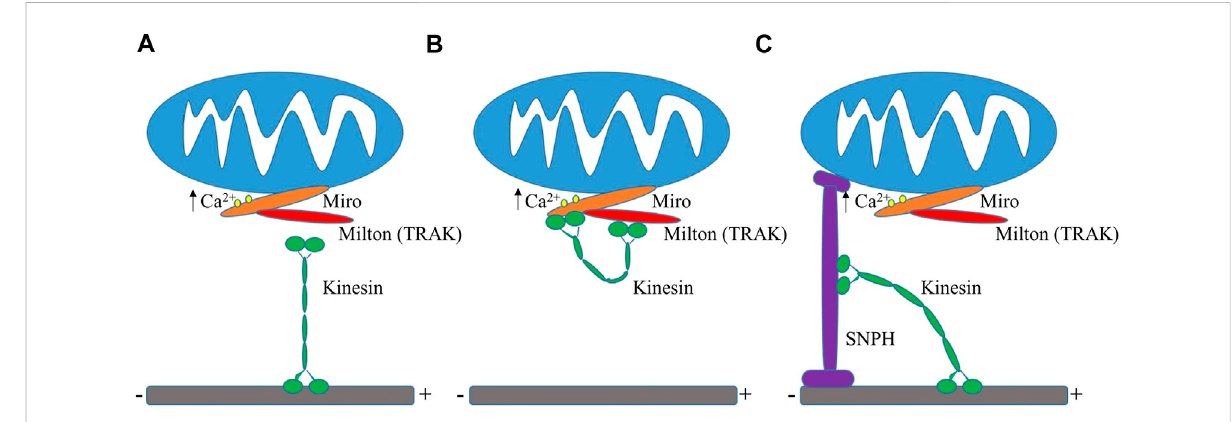
FIGURE 3 Mito-Ca2+ sensing models. (A) Ca 2+ binding to Miro results in the uncoupling of mitochondria from kinesin and the possible deactivation of motors (Macaskill etal., 2009b). (B) High levels of Ca 2+ uncouple kinesin machinery from themicrotubule, leading to its direct bindingto Miro(Wang and Schwarz, 2009). (C) Display of the “ Engine-Switch and Brake ” model in which kinesin detaches from Miro and subsequently interacts with the mitochondrial docking protein Snph (Chen and Sheng, 2013).